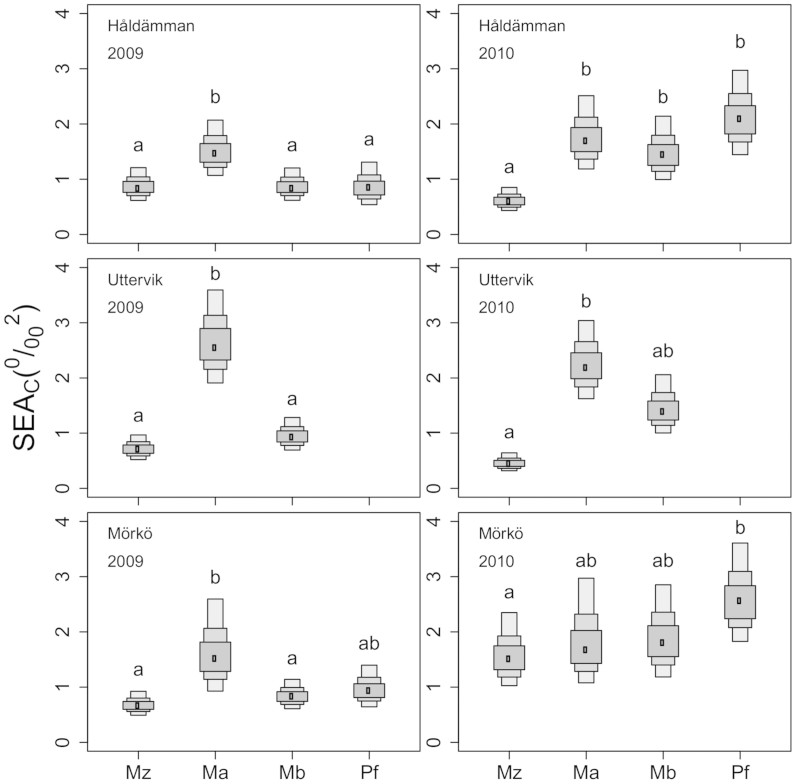
Mean standard ellipse area (SEAc) for each species at the sampling stations.Boxed areas indicates the SEAB with Bayesian 50, 75 and 95% credible interval (Ma = Monoporeia affinis, Mz = Marenzelleria arctia, Mb = Macoma balthica and Pf = Pontoporeia femorata) at the three stations in 2009 and 2010. Shared common letters denote no significant difference (P > 0.05).